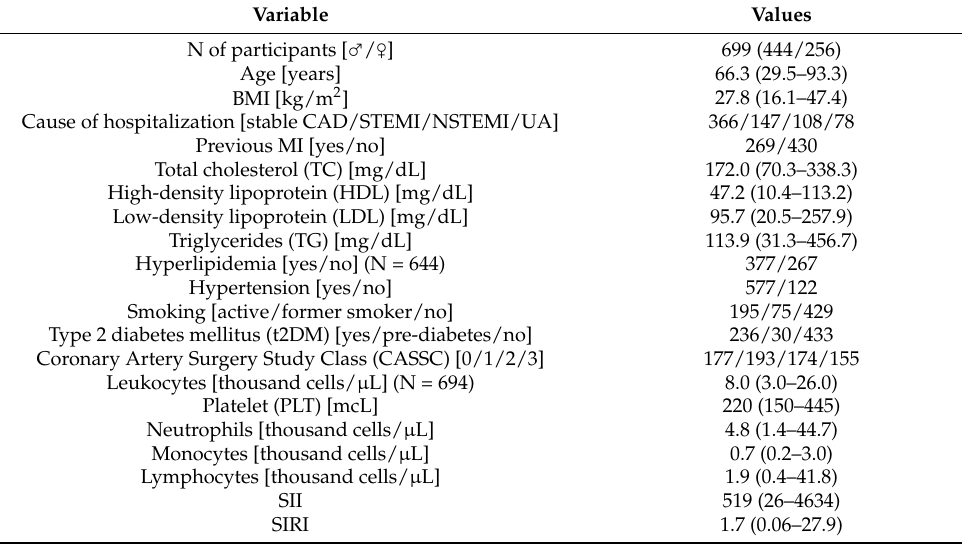
Table 1. Characteristics of participants.